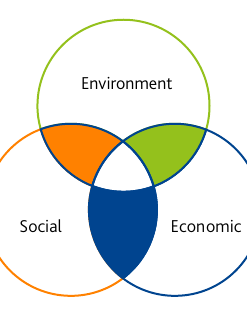
Figure 17. Three aspects